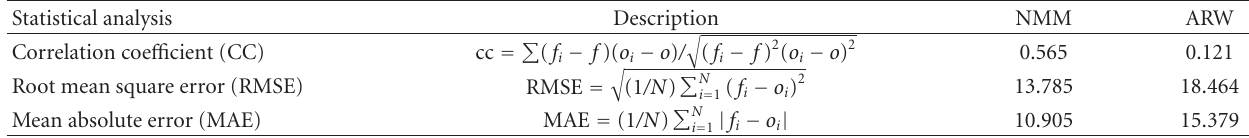
Table 5: Statistical analysis of modeled precipitation for three thunderstorm